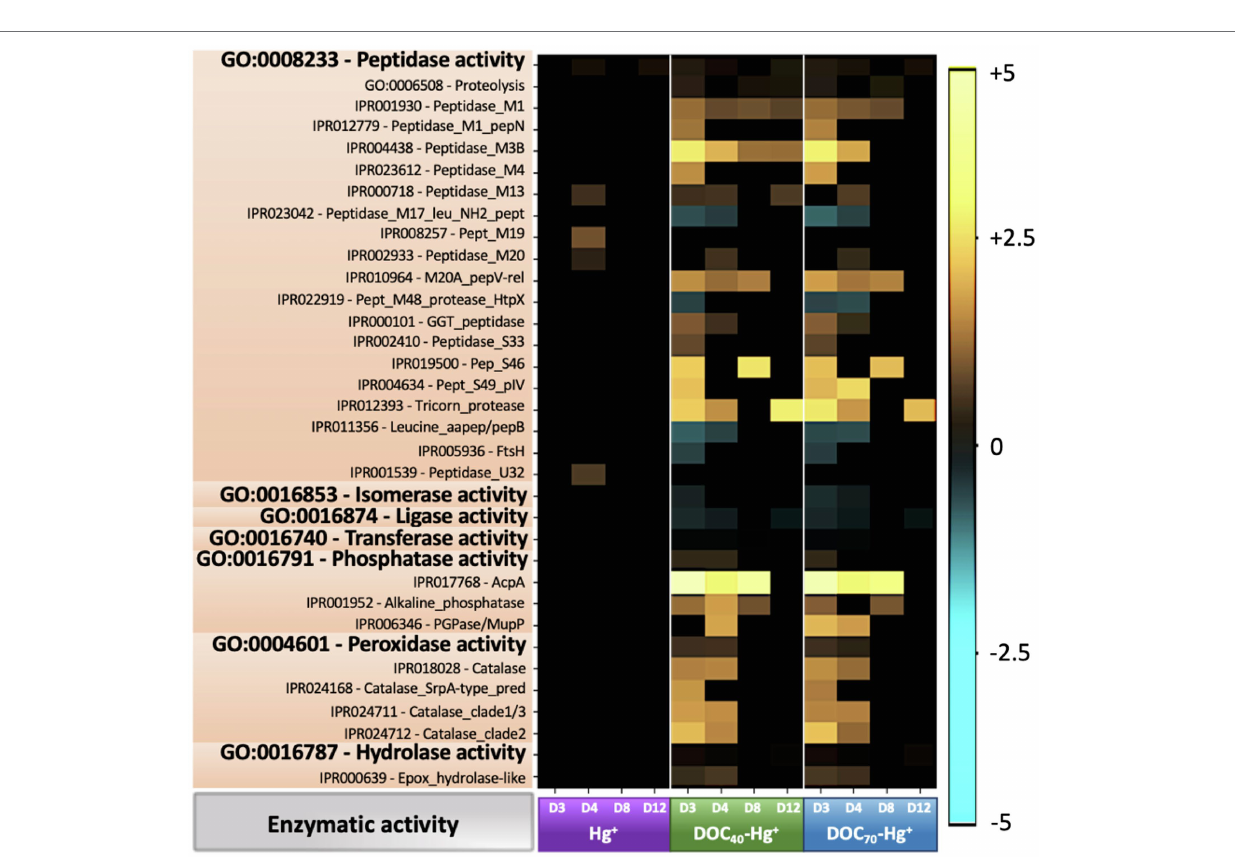
FIGURE 6 | Heatmap showing Log2 fold-change abundance of functional genes involved in different enzymatic activities from treatments Hg + , DOC 40 -Hg + , and DOC 70 -Hg + compared to the unexposed control. Warm colors (yellow) indicate overrepresentation (i.e., higher abundances), colder colors indicate underrepresentation, and black indicates non-significance ( p >